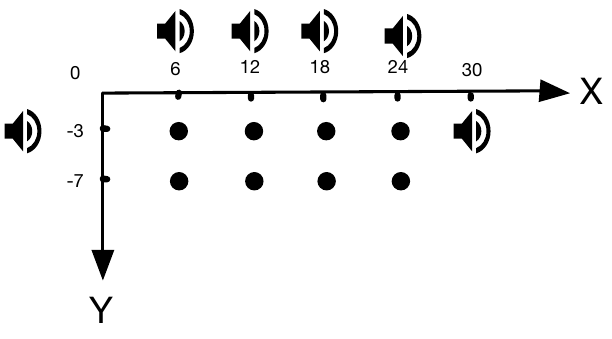
Figure 9. Acoustic Sources Settings in the evaluation.